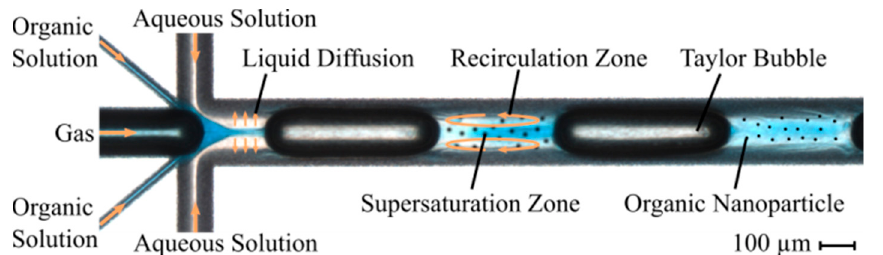
Figure 2. A microscopic image of the microfluidic system with initial flow-focusing and subsequent Taylor flow. On the left side of the image, five channels join at an intersection to enter the main channel in which the mixing process within the Taylor flow takes place. Through the middle inlet channel, the gas phase flows into the main channel. First, the channels with the organic phase and then the channel with the aqueous phase reach the intersection symmetrically from above and below the gas channel. The organic phase is colored with methylene blue for better visibility during the mixing process. The orange arrows illustrate the liquid flow in the inlet channel, the diffusion of the organic solvent into the aqueous solution, and the movement of the Taylor vortices within a plug. During the mixing process, the organic lipid supersaturates in the solvent and precipitates as nanoparticles, illustrated as black dots in the main channel.